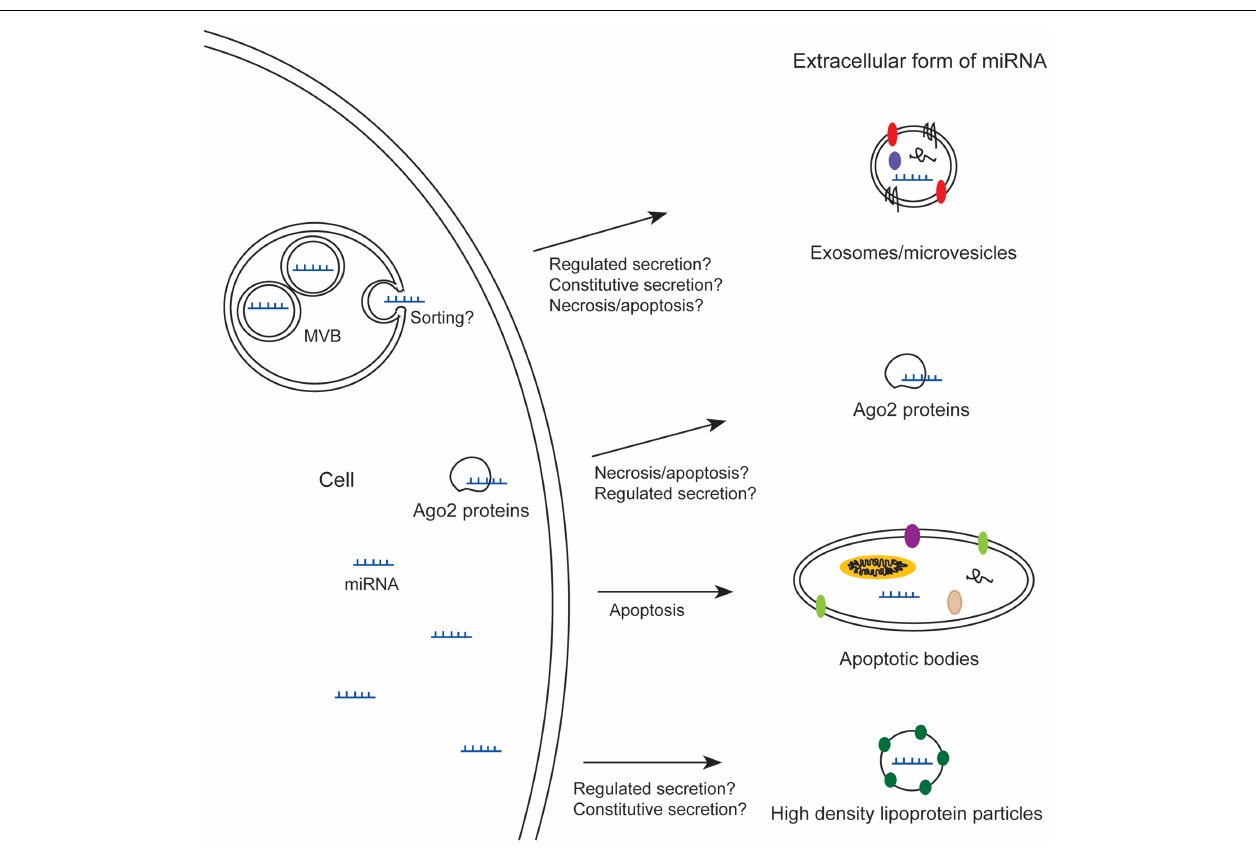
FIGURE 1 | Extracellular miRNAs exist in different forms; loaded into exosomes/microvesicles, apoptotic bodies, or high density lipoprotein particles, or associated withAgo2 proteins. MVB, multivesicular